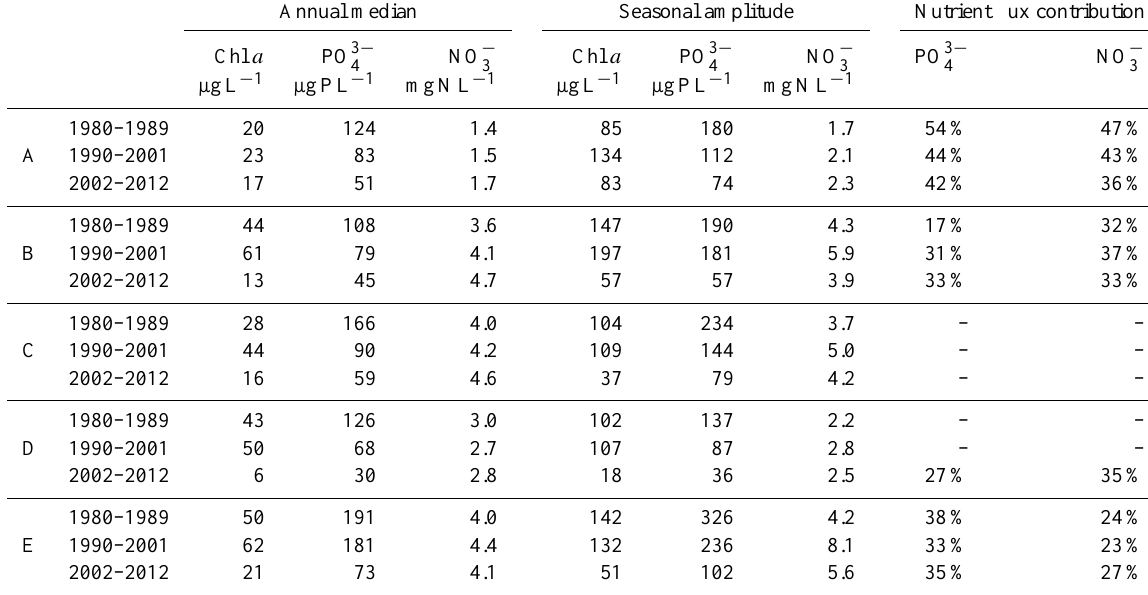
Table 5. Annual medians, DHR model seasonal amplitudes and nutrient flux contributions of the main tributaries. Annual median Seasonal amplitude Nutrient flux